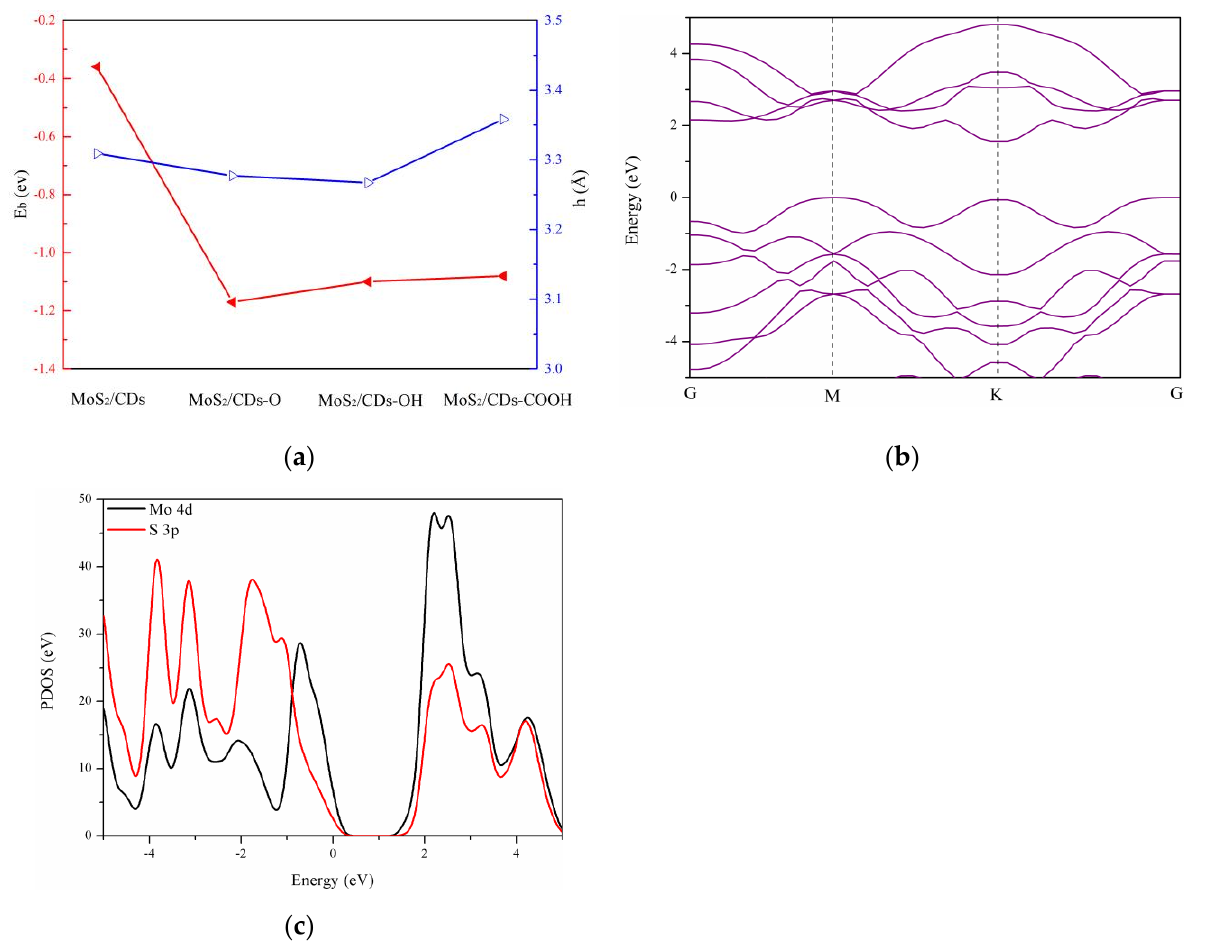
Figure 2. The binding energy (E b ) and distance (h) of MoS 2 /CDs-T ( a ), band structure of MoS 2 monolayer ( b ), and partial density of states (PDOS) of MoS 2 monolayer ( c ).